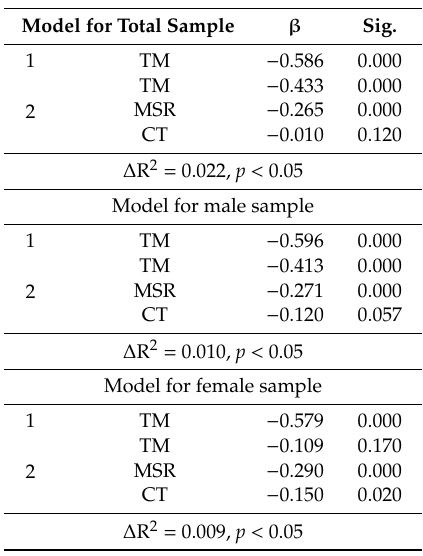
Table 2. Regression analysis in the total sample and in males and